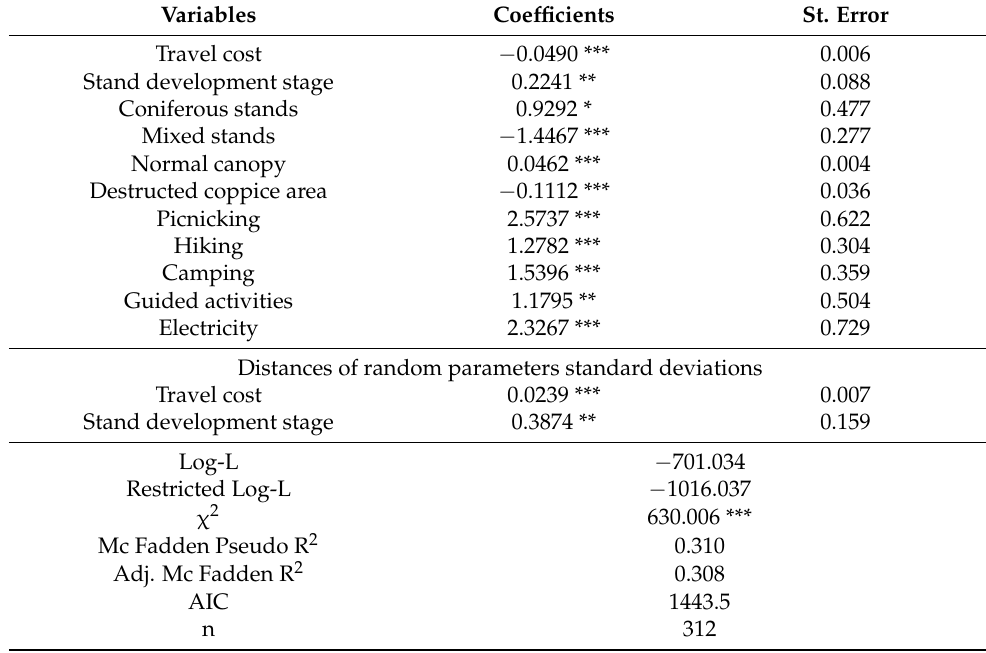
Table 2. Site choice